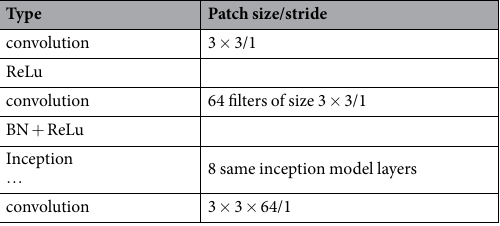
Table 1. Incarnation of the